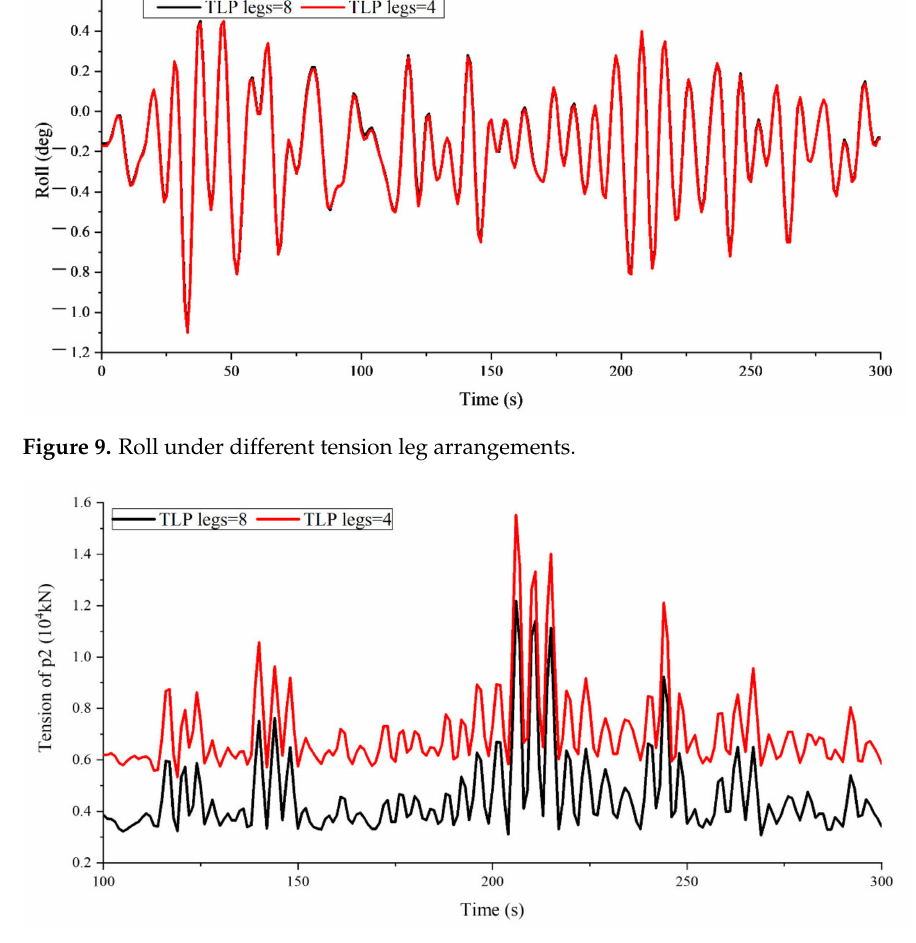
Figure 10. Tension of p2 tension leg under different tension leg